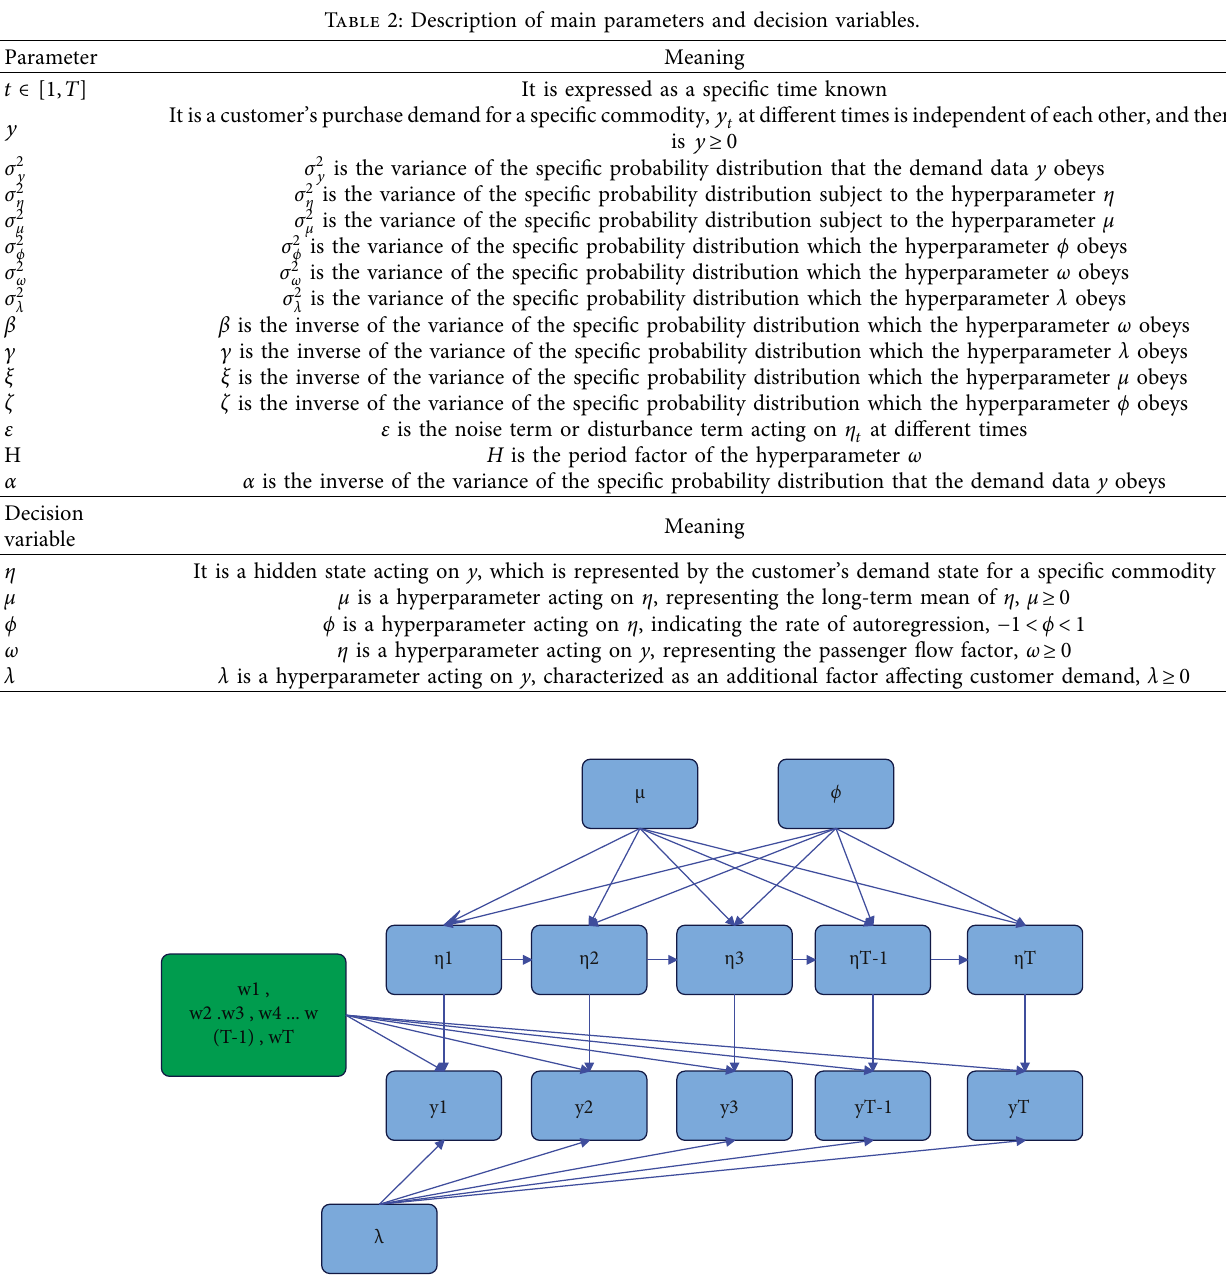
Figure 2: Probabilistic graphical model of Hiyes.